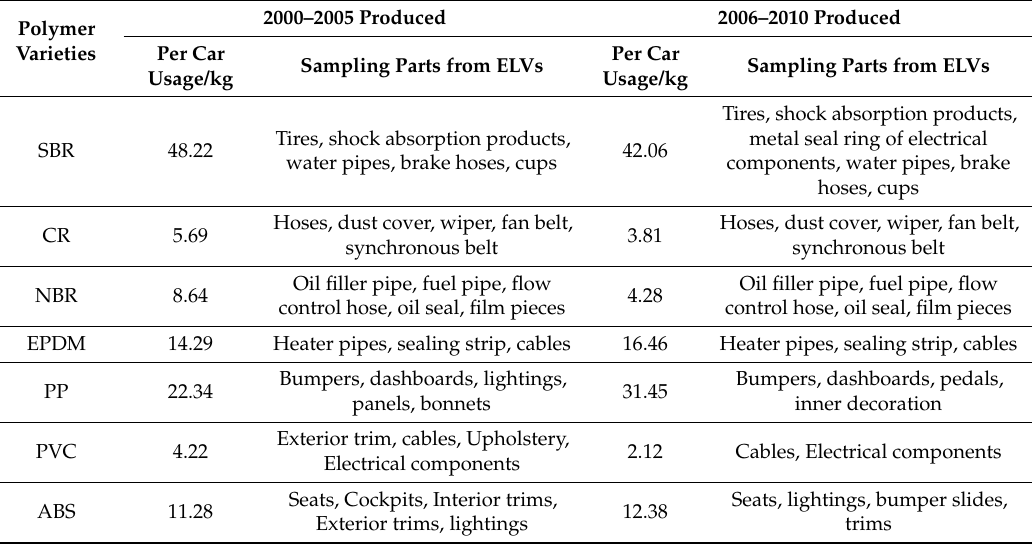
Table 1. Sampling of ASR polymers for research on domestic and foreign